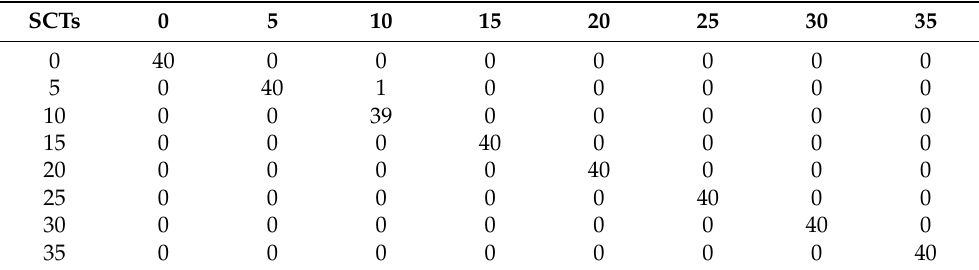
Table 3. Confusion matrix of SCTs classification using five-fold validation and k = 3.